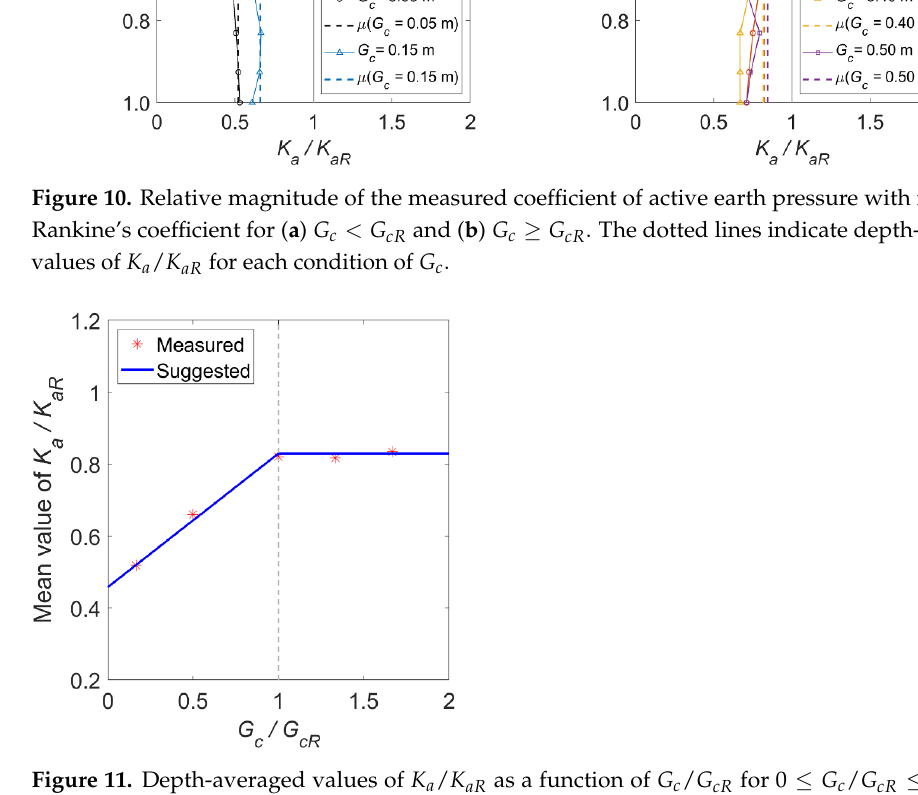
Figure 11. Depth-averaged values of K a / K aR as a function of G c / G cR for 0 ≤ G c / G cR ≤ 1.0. The blue line denotes the regression line of the measured data that are marked by red symbols.